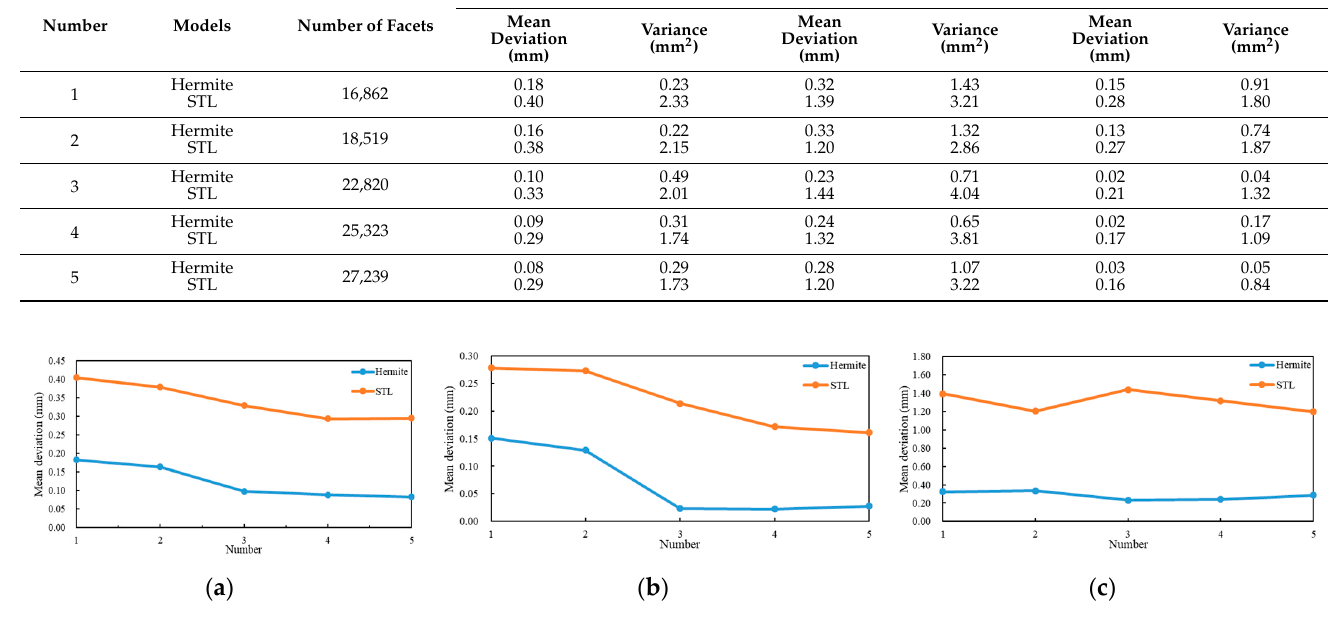
Figure 13. Variation in mean deviation: ( a ) Z-direction; ( b ) X-direction; ( c ) Y-direction. Table 4. Fi tt ing error results after removing the “noise” from the rabbit model.